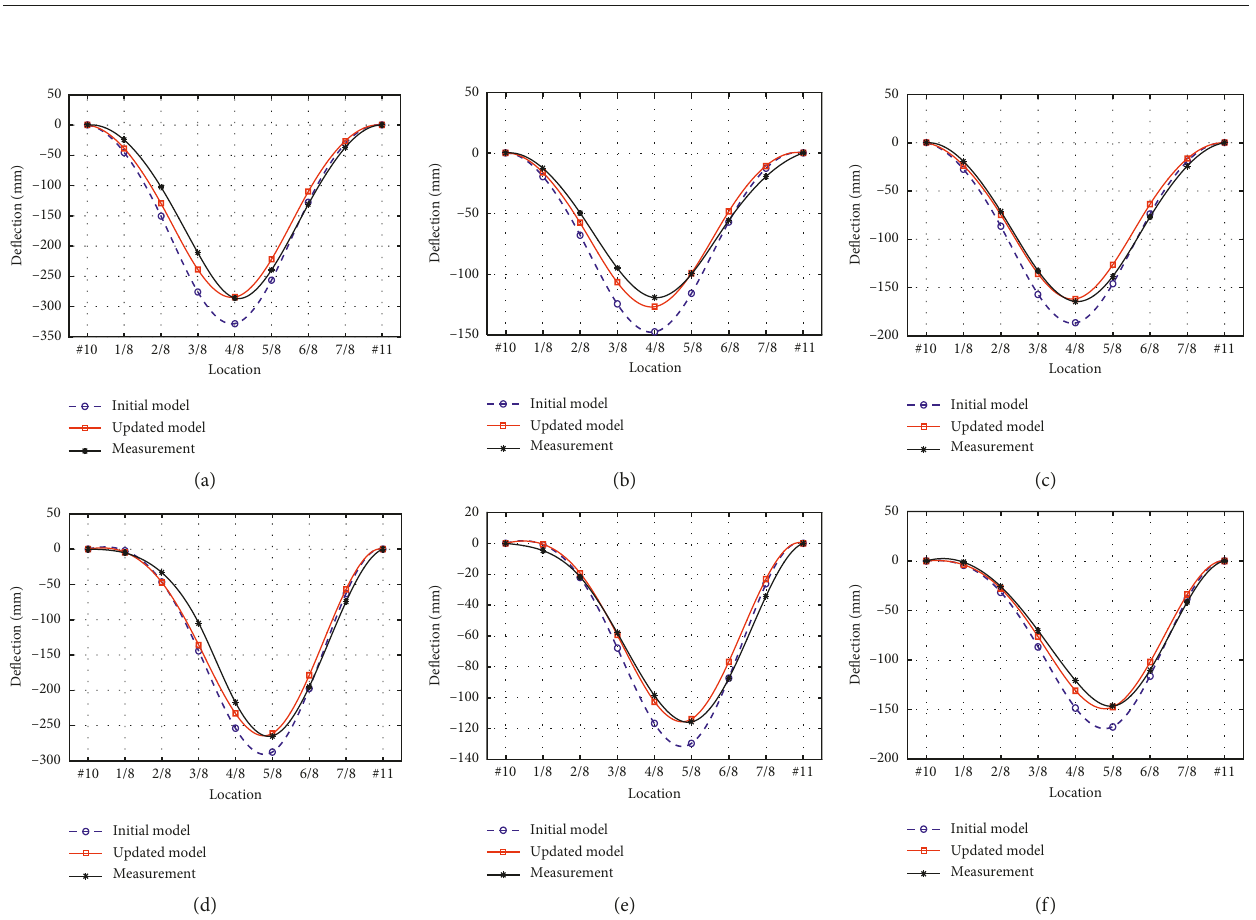
Figure 9: Comparison of the static deformation. (a) Case 1: symmetric loading. (b) Case 1: north defection with partial loading. (c) Case 1: south deflection with partial loading. (d) Case 2: symmetric loading. (e) Case 2: north defection with partial loading. (f) Case 2: south deflection with partial